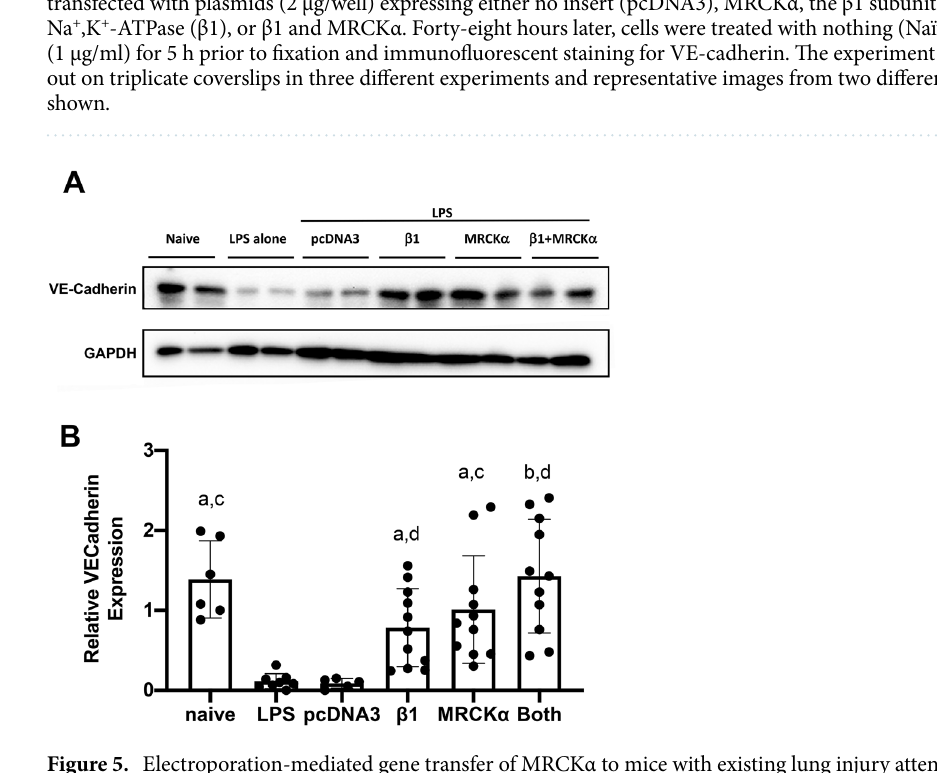
Figure 5. Electroporation-mediated gene transfer of MRCKα to mice with existing lung injury attenuates LPS-induced reduction in VE-cadherin. Lung injury was established in C57B6 mice (n = 6–12) by aspiration of LPS (5 mg/kg) and 1 day later plasmids (100 µg each) expressing either no insert (pcDNA3), the β1 subunit of the Na + ,K + -ATPase (β1), MRCKα, or β1 and MRCKα were delivered in 50 µl to the lungs by aspiration followed immediately by electroporation (8 pulses of 10 ms duration each and 200 V/cm). Two days later (3 days after LPS administration), lungs were perfused with PBS and lysates were used for Western blots of VE-cadherin expression ( A ). Levels of expression were normalized to GAPDH as a loading control and the relative expression of VE-cadherin ( B ) is shown as mean ± SEM. All experiments were carried out three times and representative experiments are shown. One-way ANOVA with post-hoc Tukey’s multiple comparisons was used for statistical analysis; a, p < 0.05 compared to LPS only; b, p < 0.01 compared to LPS only; c, p < 0.05 compared to pcDNA3; and d, p < 0.01 compared to